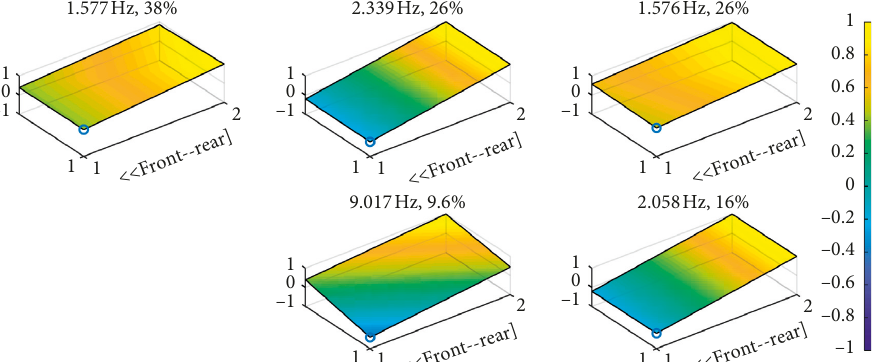
Figure 18: Modal parameters identified by CoS-SSI. (a) J